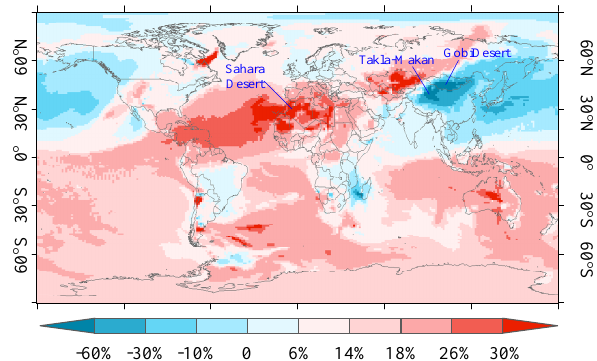
Figure 13. Relative differences in simulated Fe concentrations at- tached to aerosols in surface air when using the new mineralogical data and prescribing a constant Fe content in dust (3.5%). A posi- tive difference indicates a higher Fe concentration when using the new mineralogical data.